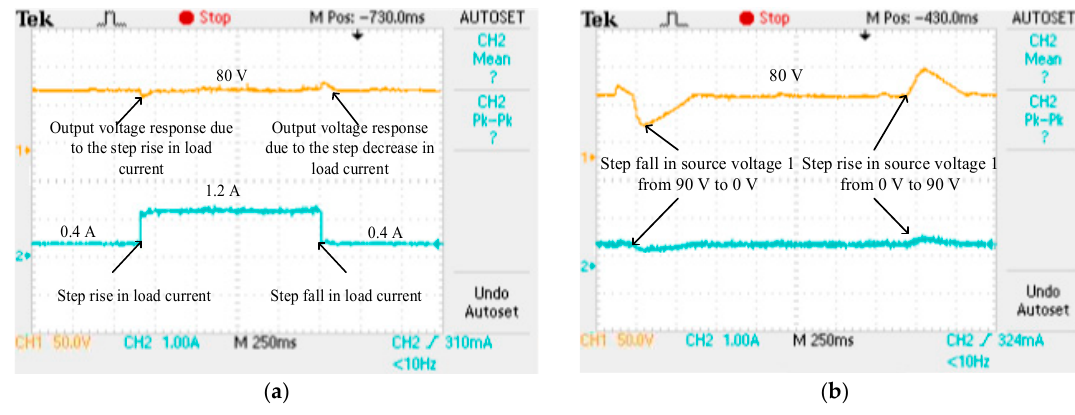
Figure 13. Experimental waveforms of the output voltage and load current of the MBDC converter (CH1: 20 V/div, CH2: 1 A/div): ( a ) under load variations; and ( b ) under source variations.